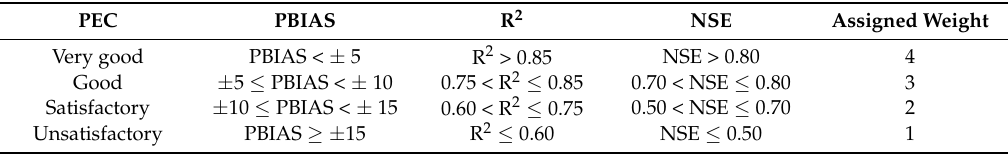
Table 2. The performance evaluation criteria (PEC), statistical threshold values, and corresponding assigned